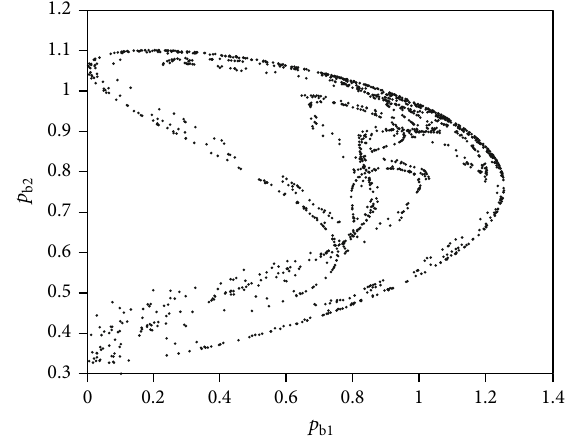
Figure 4: The maximum Lyapunov exponent with respect to λ corresponding to Figure